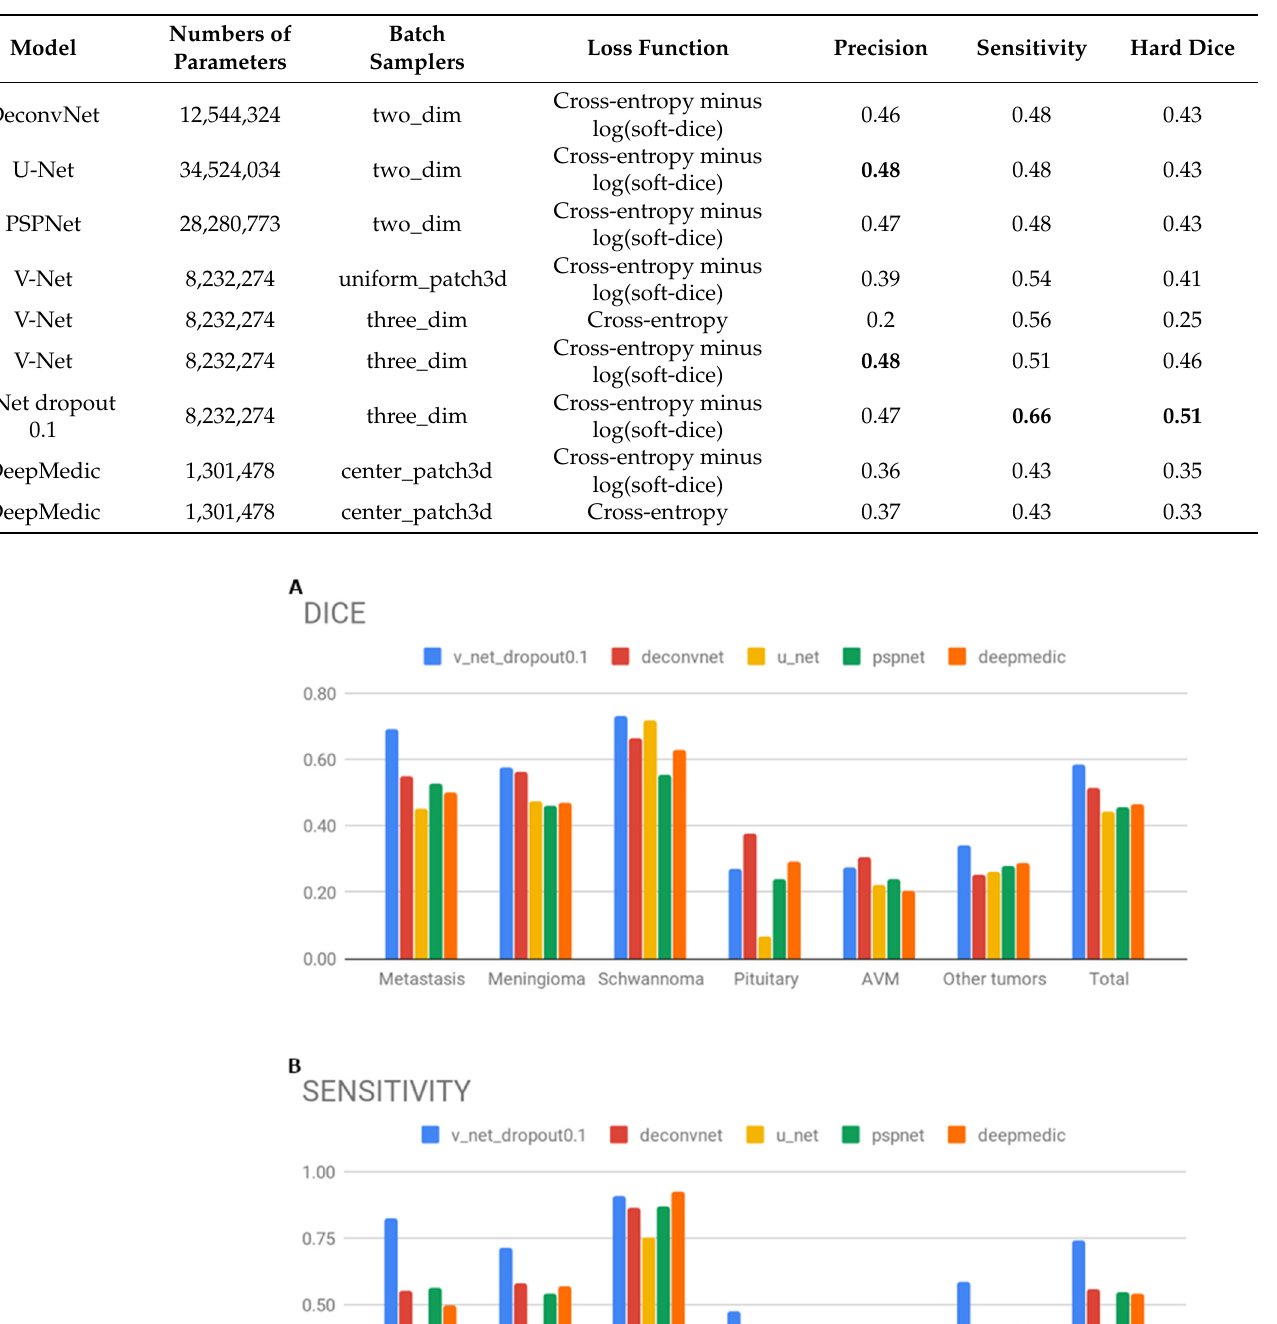
Figure 1. Bar chart results of ( A ) dice score; ( B ) sensitivity; and ( C ) precision of deep learning-based segmentation versus ground truth on different lesion types in the NTUH dataset.